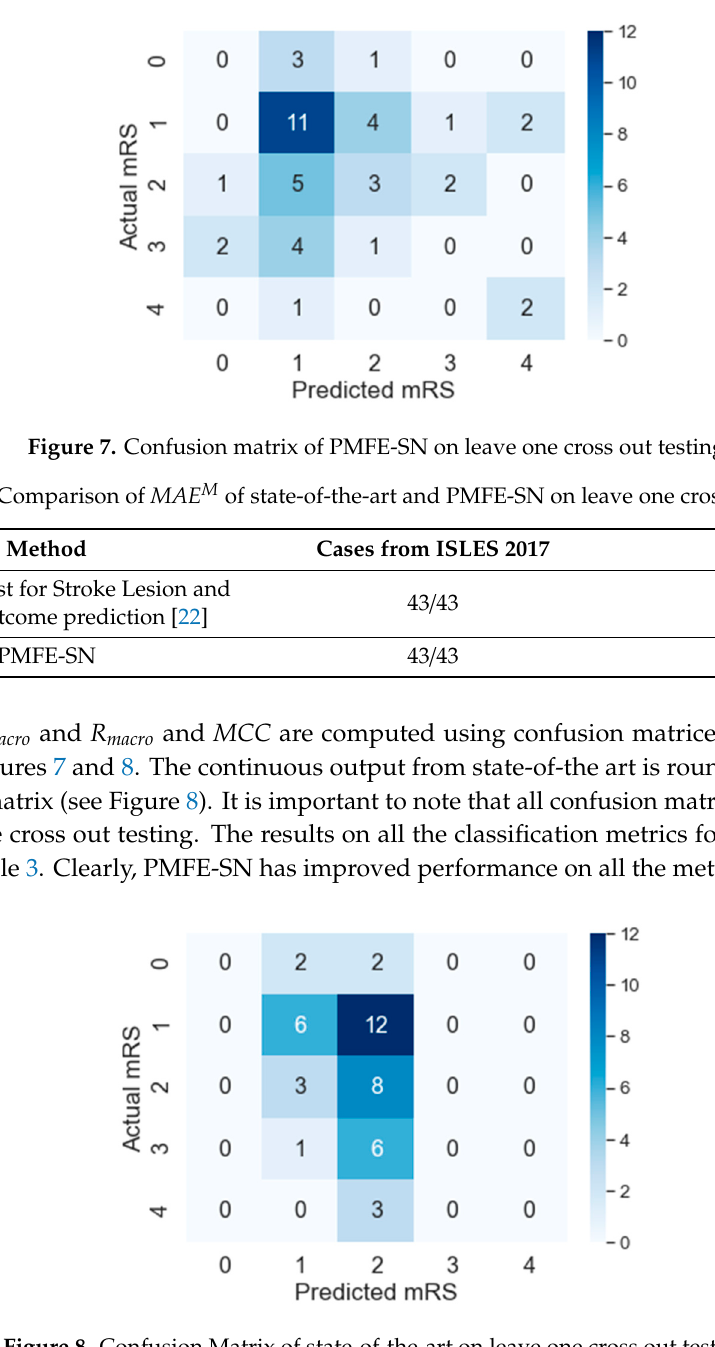
Figure 8. Confusion Matrix of state-of-the-art on leave one cross out testing. Table 3. Comparison of P macro , R macro , F 1 macro and Matthews correlation coe ffi cient (MCC) of state-of-the-art and PMFE-SN on leave one cross out testing.